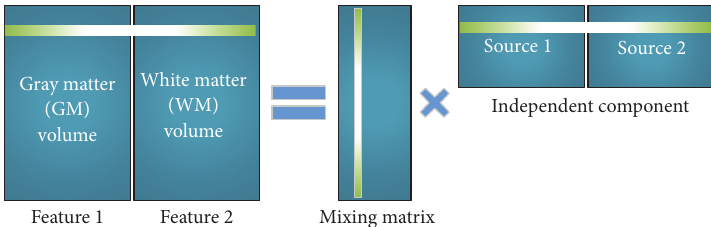
Figure 7: Joint ICA schematic diagram. The independent component analysis (ICA) model in which a subject in grey and white matter matrix was decomposed into mixing matrix and source